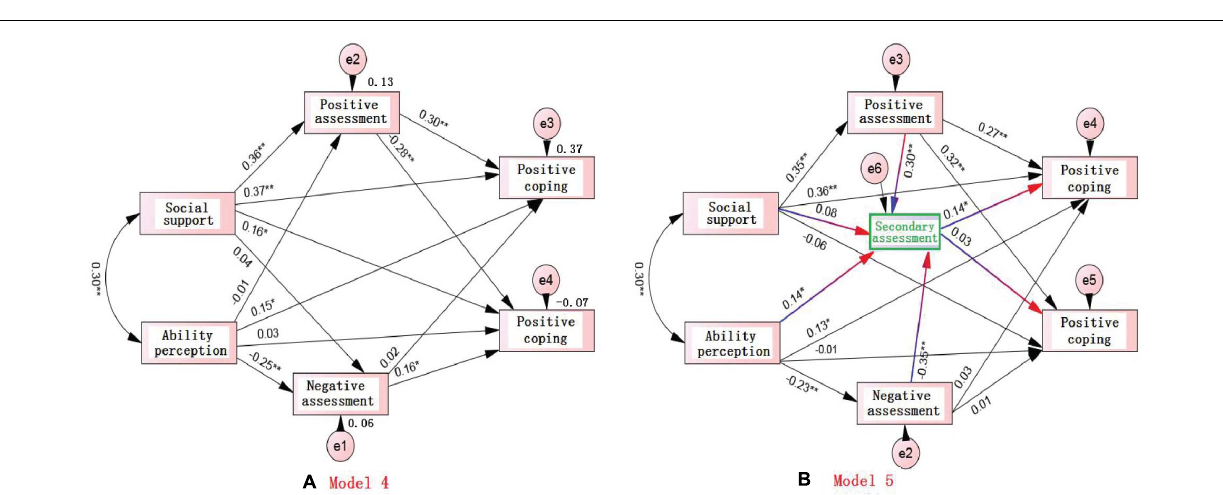
FIGURE 1 | The effects of social support and ability perception on primary and secondary assessments: (A) Model 1: Direct effects of social support and ability perception on primary assessment; (B) Model 2: Direct effects of social support and ability perception on secondary assessments; (C) Model 3: Effects of social support and ability perception on secondary assessments via the mediating role of primary assessments.